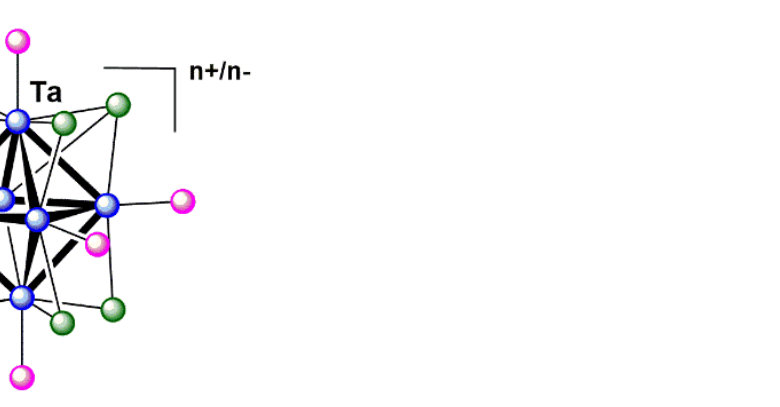
Figure 1. General representation of the octahedral [{Ta 6 X i 12 }L a 6 ] n+/ − (circles in blue = Ta; green = X i ; pink = L a ) cluster unit.